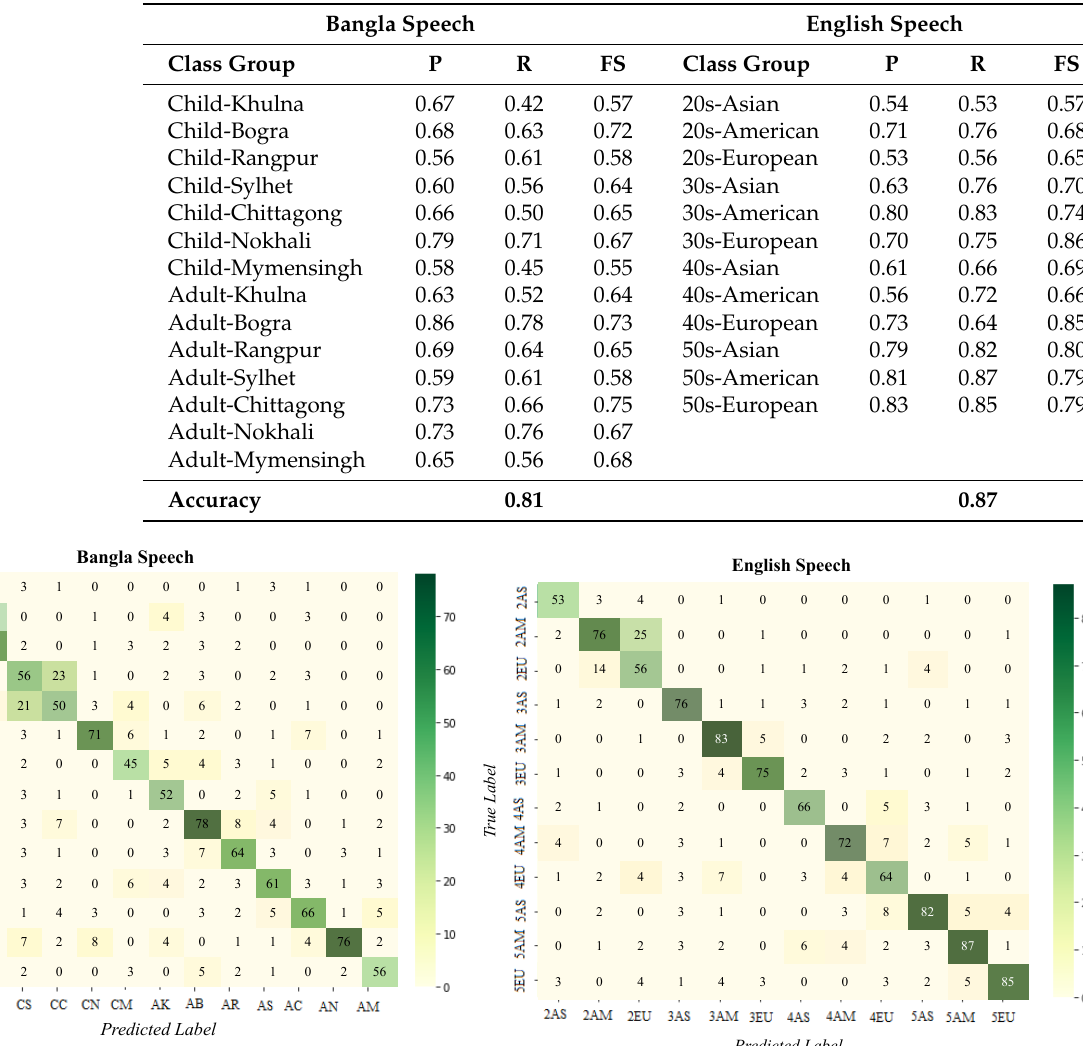
Table 5. Classification Results of Dialect and Age Correlation for Bangla and English Speech Precision (P), Recall (R), and f1-score (FS) using the SCAE-MLELMs model.